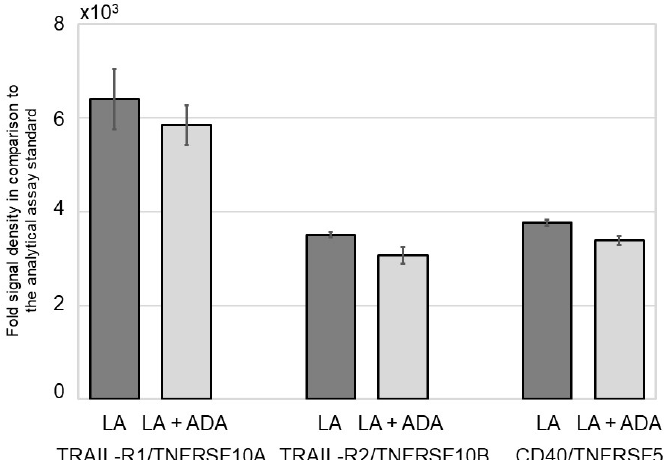
Figure 1. Evaluation of the NF κ B signal pathway members TRAIL-R1/TNFRSF10A, TRAIL- R2/TNFRSF10B, and CD40/TNFRSF5 in normal human NHK-19 keratinocytes after 24 h pre-incubation with linoleic acid (LA, 10 − 4 M) and subsequent treatment with LA or LA and adalimumab (ADA, 30 μ g/mL) over 3 days. Comparative quantification of the obtained data against the analytical assay standard.